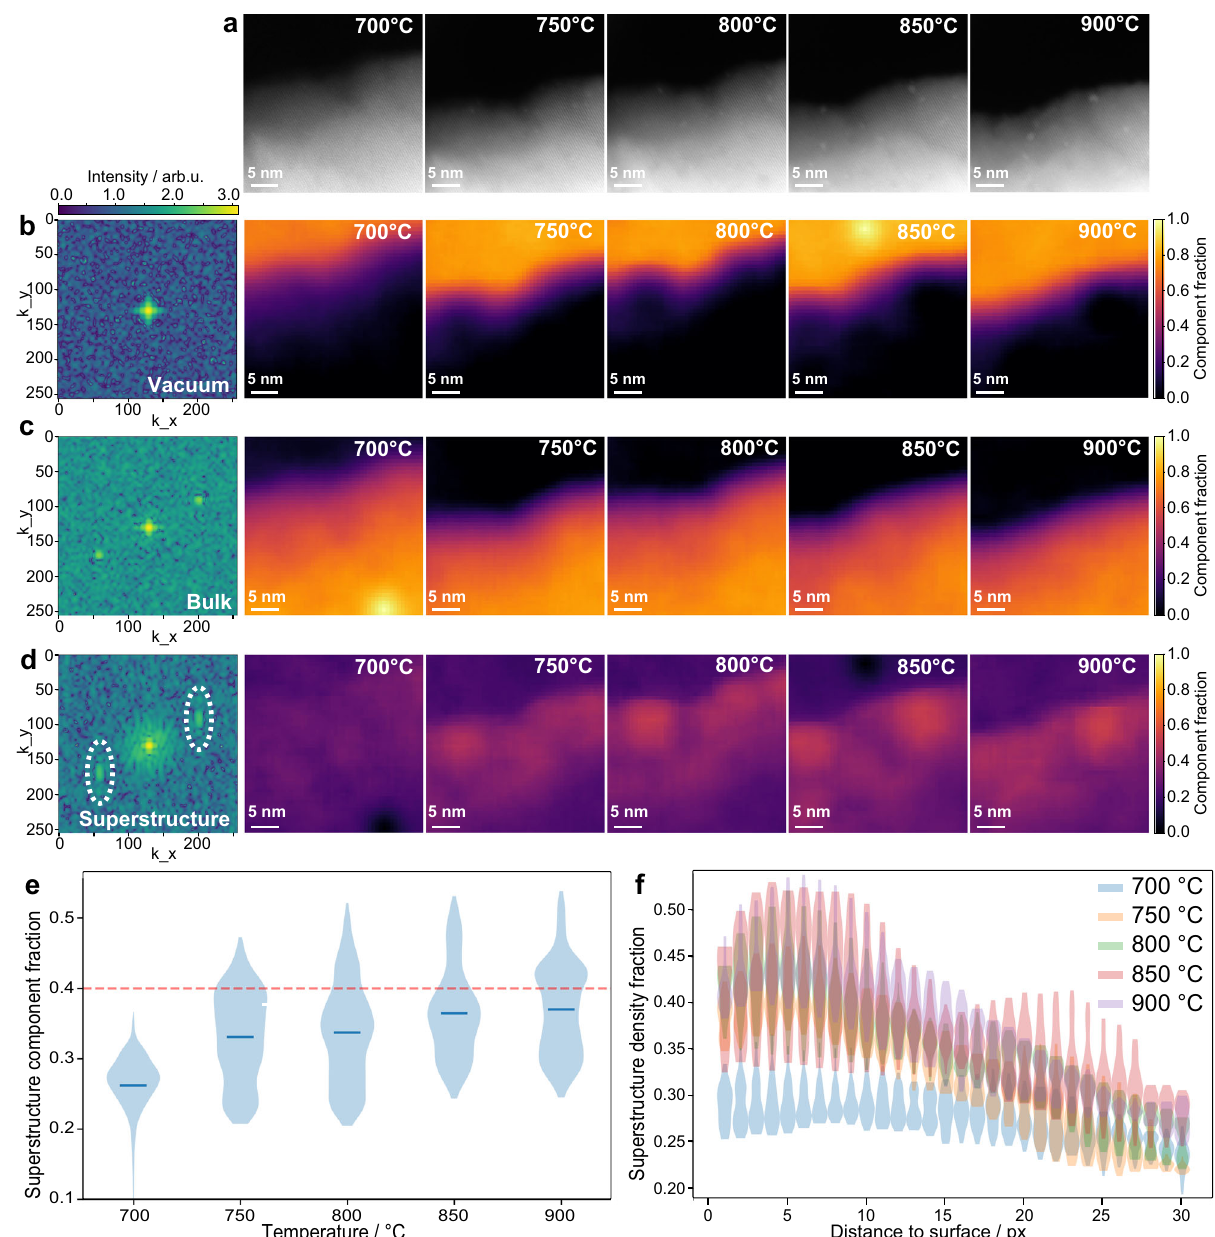
Fig.4|AnalysisofinsituSTEMimagesviatheN-FINDRmethod.a STEMimages of a 0.5% Ir-doped STO grain used for the N-FINDR analysis acquired in situ at 700 – 900°C. b – d Thethreeendmembers(vacuum( b ),bulk( c ),andsuperstructure ( d )) extracted through the sliding FFT window approach, with corresponding resulting spatial abundances for each temperature targeted between 700 and 900°C. The superstructure component is dashed circled for easier visualisation. e Plot of the density of the superstructure component as a function of target temperature.Reddashedlineisat40%fractionasaguidetotheeye. f Violinplotof